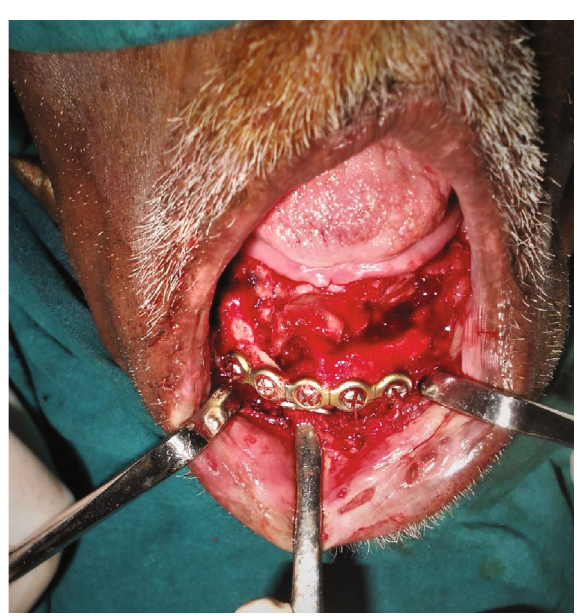
Figure 6: On-table exposure of the fracture site ( fi rst surgery).